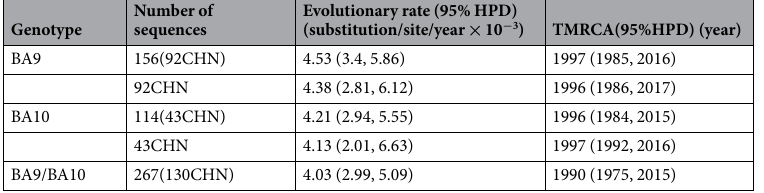
Table 2. Evolutionary rates and TMRCA of genotypes BA9 and BA10. CHN: Chinese sequences; HPD: Highest probability density; TMRCA: Time to the most recent common ancestor.